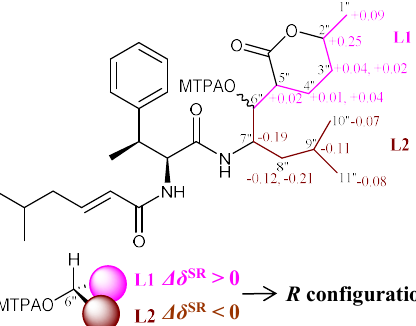
Figure 2. ∆ δ SR values measured for the MTPA esters of mintaimycin A 1 ( 1 ). Figure 2. Δδ SR values measured for the MTPA esters of mintaimycin A 1 ( 1 ). Figure 2. Δδ SR values measured for the MTPA esters of mintaimycin A 1 ( 1 ).